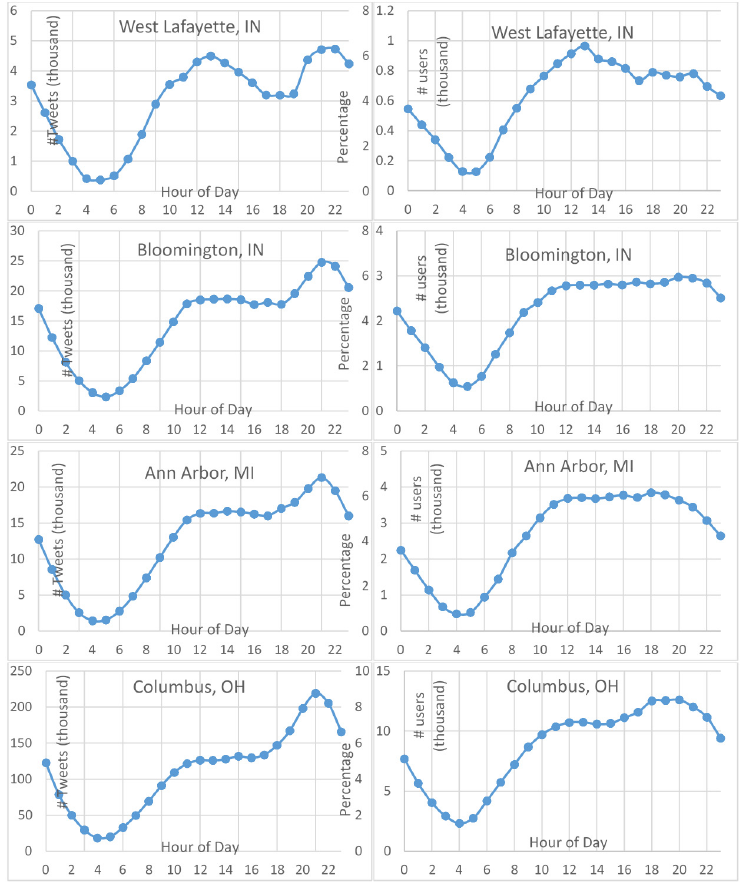
Figure 3. Distribution of number of hourly tweets ( left ) and users ( right ) for the four cities. There were more users during weekends than weekdays. The average number of tweets per